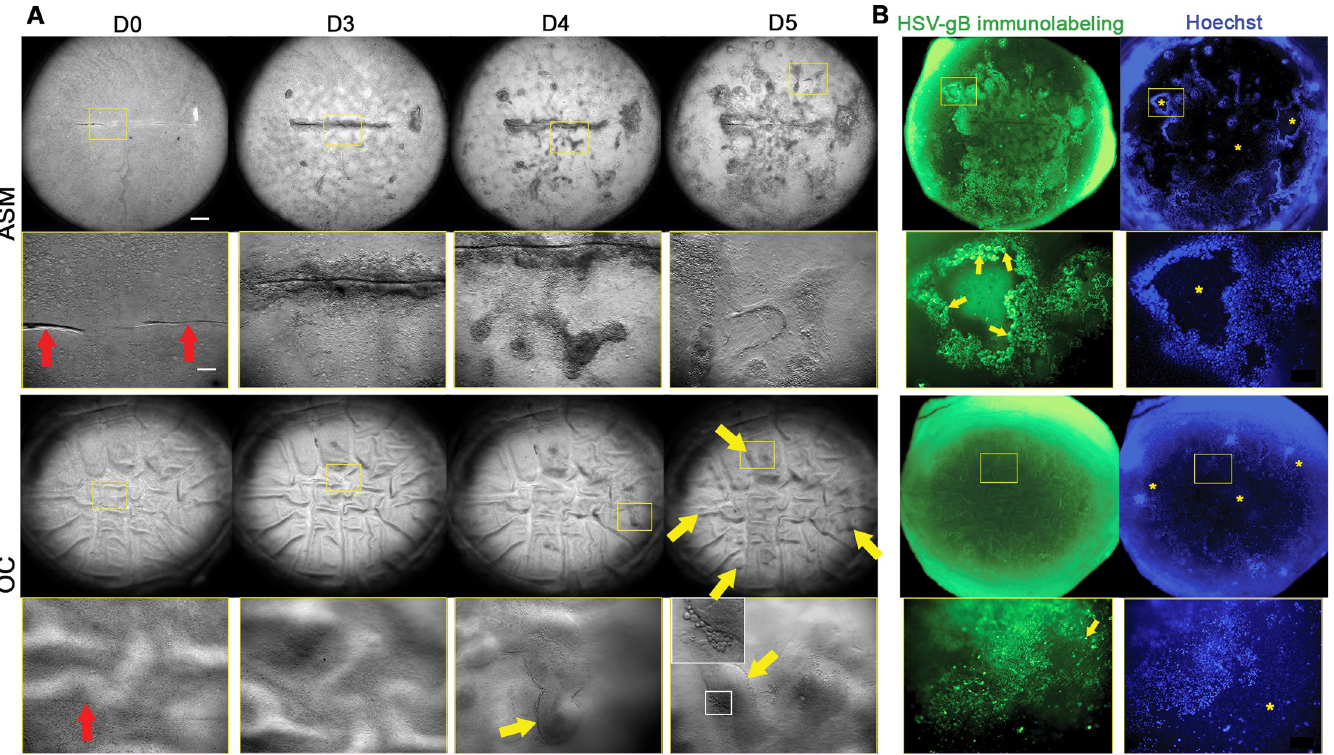
Fig 3. Ex vivo models of herpetic lesions on corneas. (A) Chronology of the development of herpetic lesions on the corneas stored in the active storage machine (ASM) versus organ culture (OC). Bright field macroscopic observation (x1 and x6.3 zooms) after scratching (D0) and infection at D3, D4 and D5. In the OC cornea, the red arrows show the initial scratch; and the yellow arrows, the "buds" that appeared at the edges of the infected area. Note that the OC cornea presented a characteristic tessellated pattern (highlighted by retro illumination) corresponding to the numerous deep posterior folds caused by stromal edema. On the contrary, the ASM-stored cornea was thinner, presented no folds and thus appeared smooth. (B) Anti HSV-gB immunolabeling on unfixed whole human corneas. Observation with a fluorescence macro-zoom microscope (x1 and x6.3 zooms) of the corneal epithelium infected with HSV-1 in the ASM or OC and labeled with anti-HSV-gB and Hoechst after 5 days’ incubation in the ASM or OC. Yellow asterisks show full-thickness epithelial ulcers where nuclei of Hoechst-positive keratocytes were visible through transparency. Yellow arrows show the rounded infected cells demonstrating the cytopathogenic effect (CPE). Note that the corneal limbus and the scleral rim were strongly autofluorescent on this wavelength, but this did not prevent corneal imaging. Scale bar: 1000 μ m for low magnification images and 200 μ m for high magnification images.